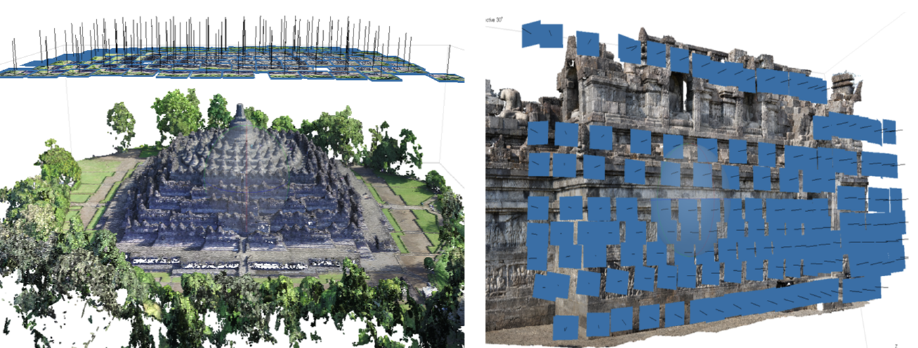
Figure 4. The camera positions of the two proposed strategies: the remote photography is on the left and the close-range photography is on the right. The blue box in the picture shows the direction and the position of the camera while taking the target